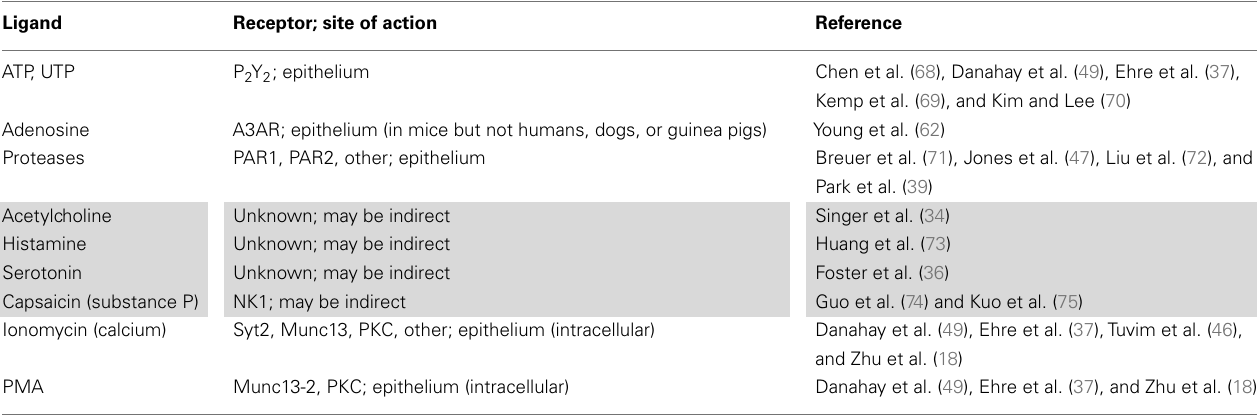
Table 1 | Ligands shown to induce mucin